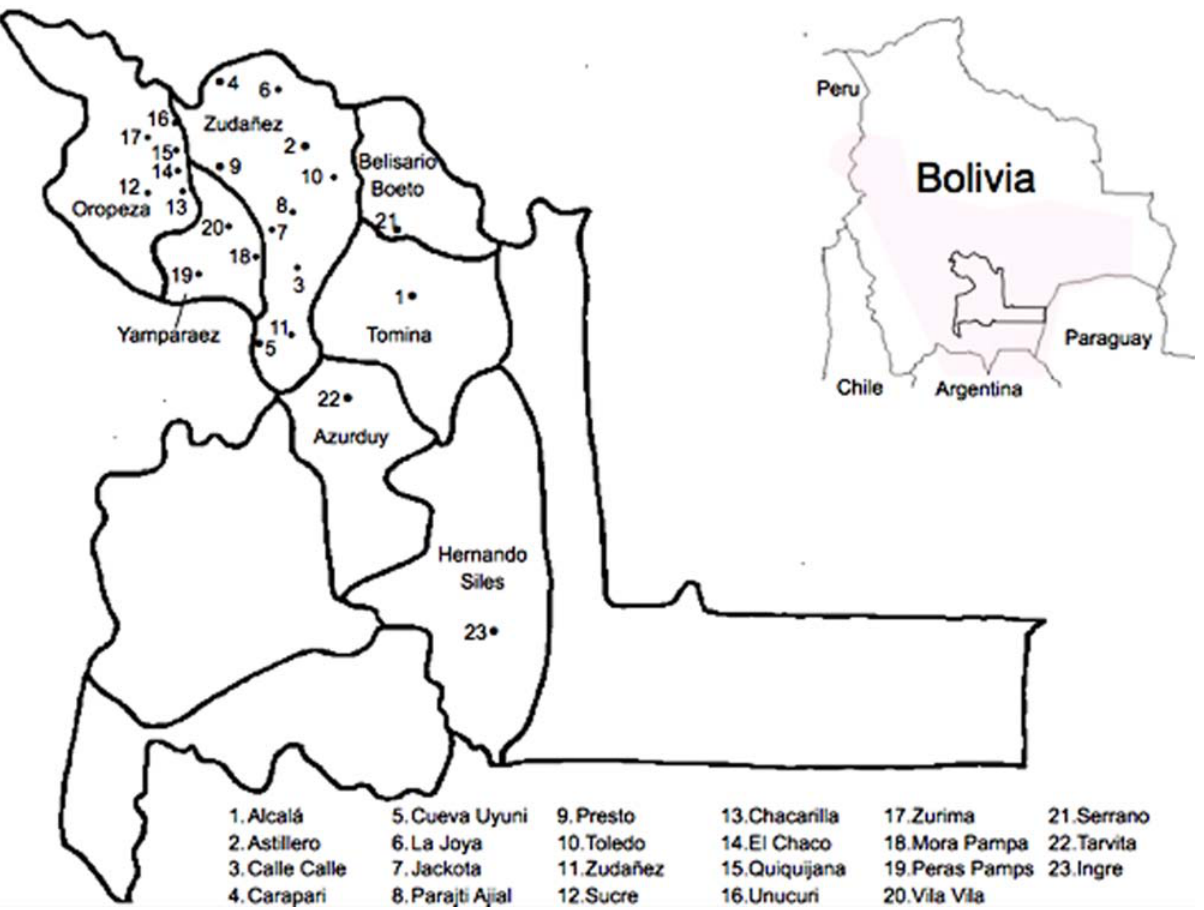
Figure 1. Distribution of T.infestans in Bolivia (shaded area) and locations of sample sites in Chuquisaca.